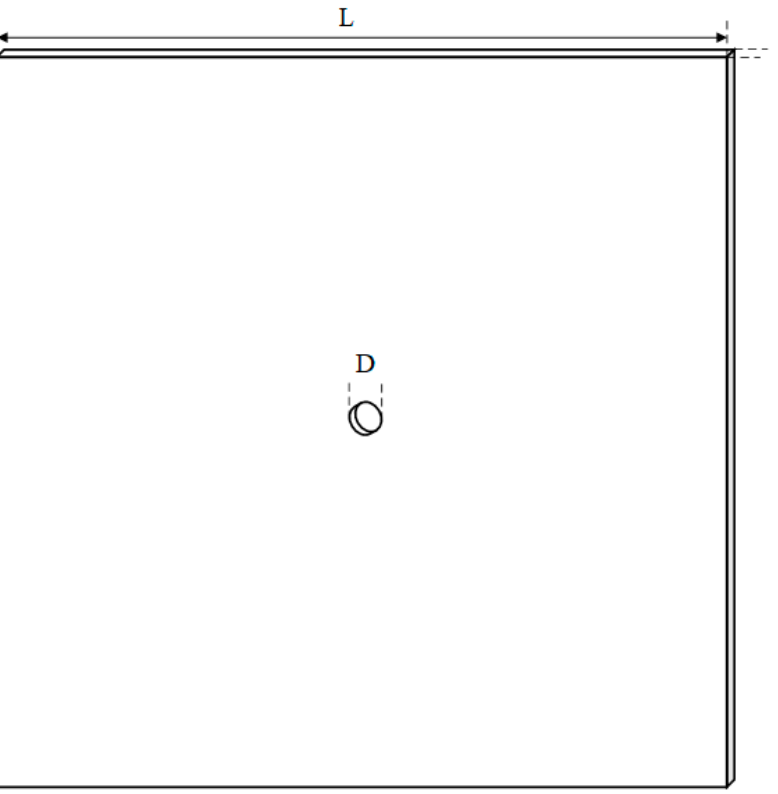
Figure 5. Three-dimensional model of the plate with dimensions. Table 4. Natural frequency errors between the experimental and FE modal-analysis results.